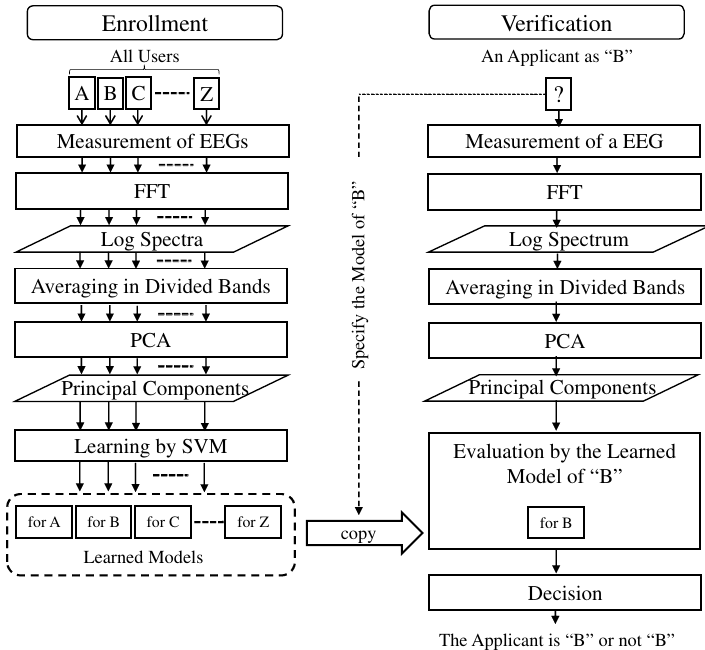
Figure 10. Verification procedure using support vector machine (SVM) and principal component analysis